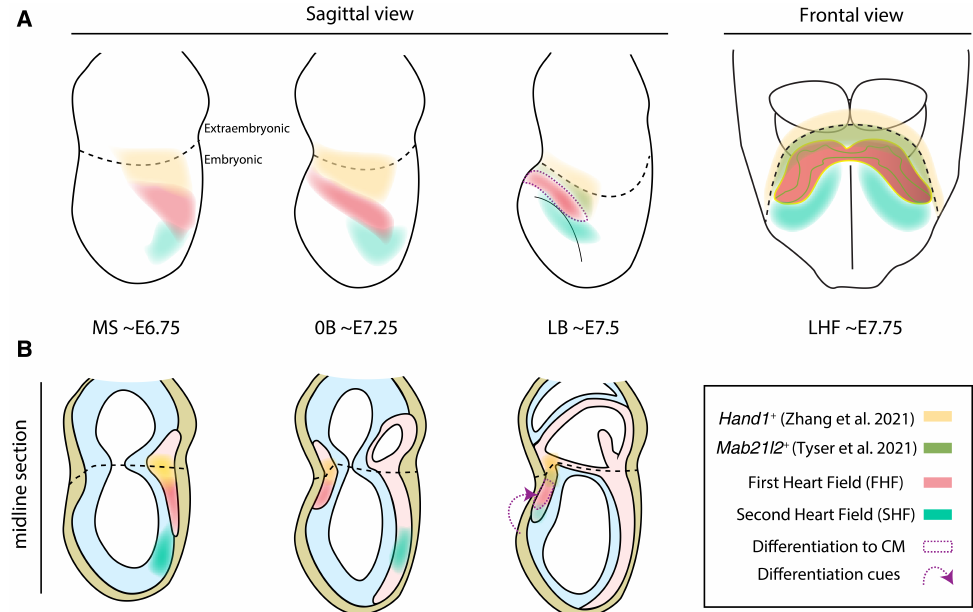
Figure 2. Progenitor domains contributing to heart tube cell populations in the mouse. Diagrams show whole embryos ( A ) and midline sections ( B ). Notice how the First Heart Field (FHF), Second Heart Field (SHF) and the recently characterized Mab21l2 / Hand1 population stay in a continuum until differentiation cues recruit the FHF to form the primitive heart tube. In the section diagrams ( B ), endoderm, epiblast and mesoderm are painted in yellow, cyan and light red, following Figure 1 color code. Diagrams were done based on